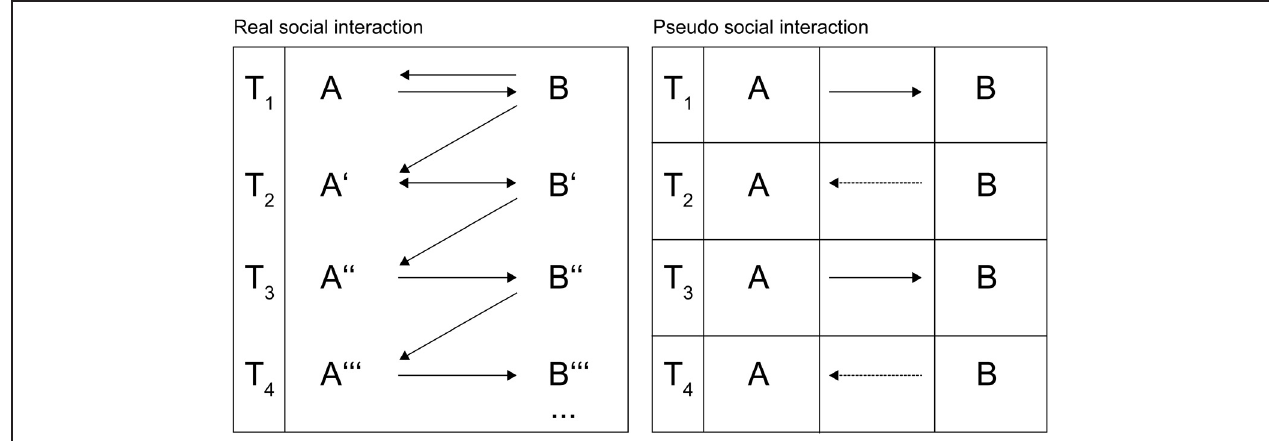
FIGURE 1 | Two models of social